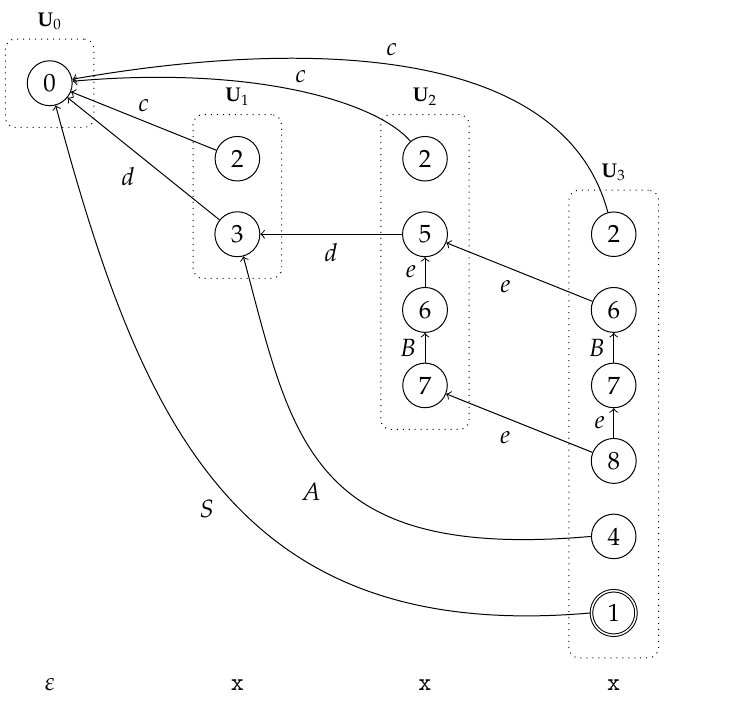
Figure 17. The GSS constructed by our architecture using the specification Ξ in (4).